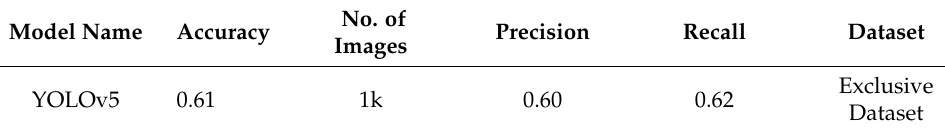
Table 5. YOLOv5 on exclusive dataset.